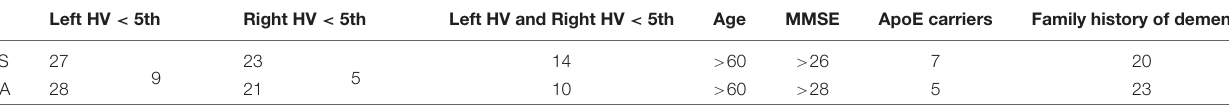
TABLE 2 | Characteristics of ADNI subjects below 5th percentile.